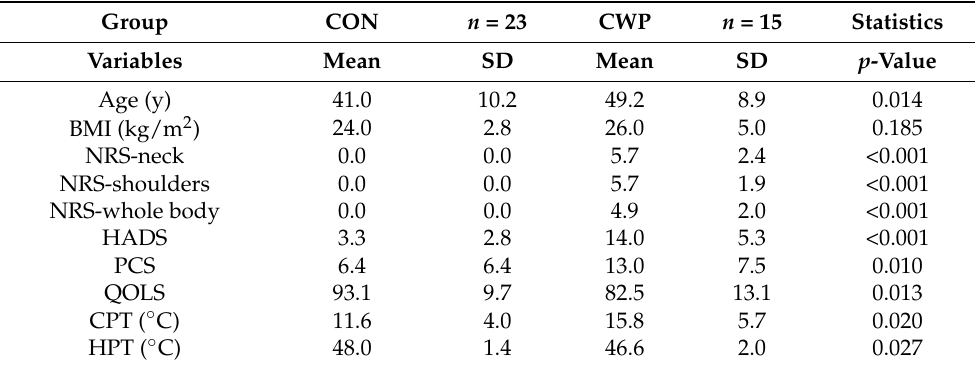
Table 1. Background and PROM data (mean and SD) together with CPT and HPT over trapezius (mean of right and left sides and SD) for CON and CWP groups. Most of the background and PROM data were published elsewhere